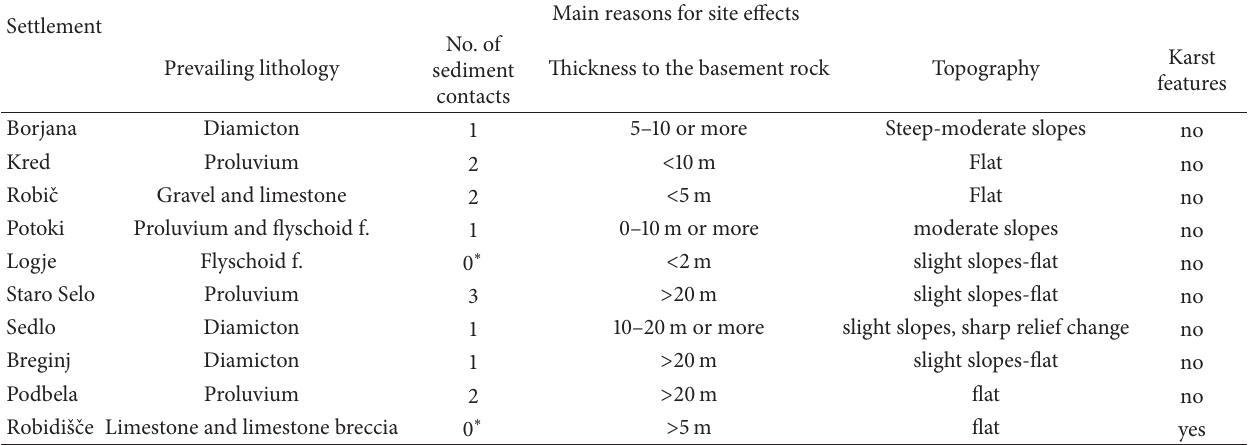
Table 4: Main reasons for significant site effects in settlements of Breginjski kot.